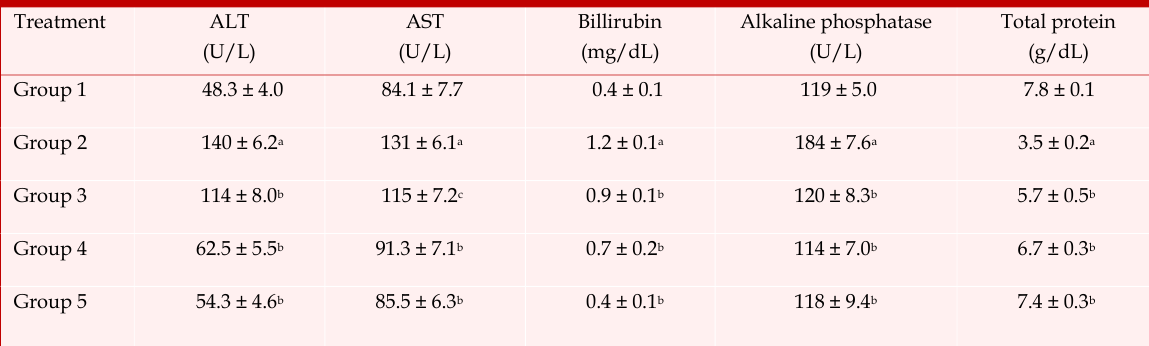
Effect of Monotheca buxifolia on isoniazid- and rifampicin-induced hepatotoxicity in rats